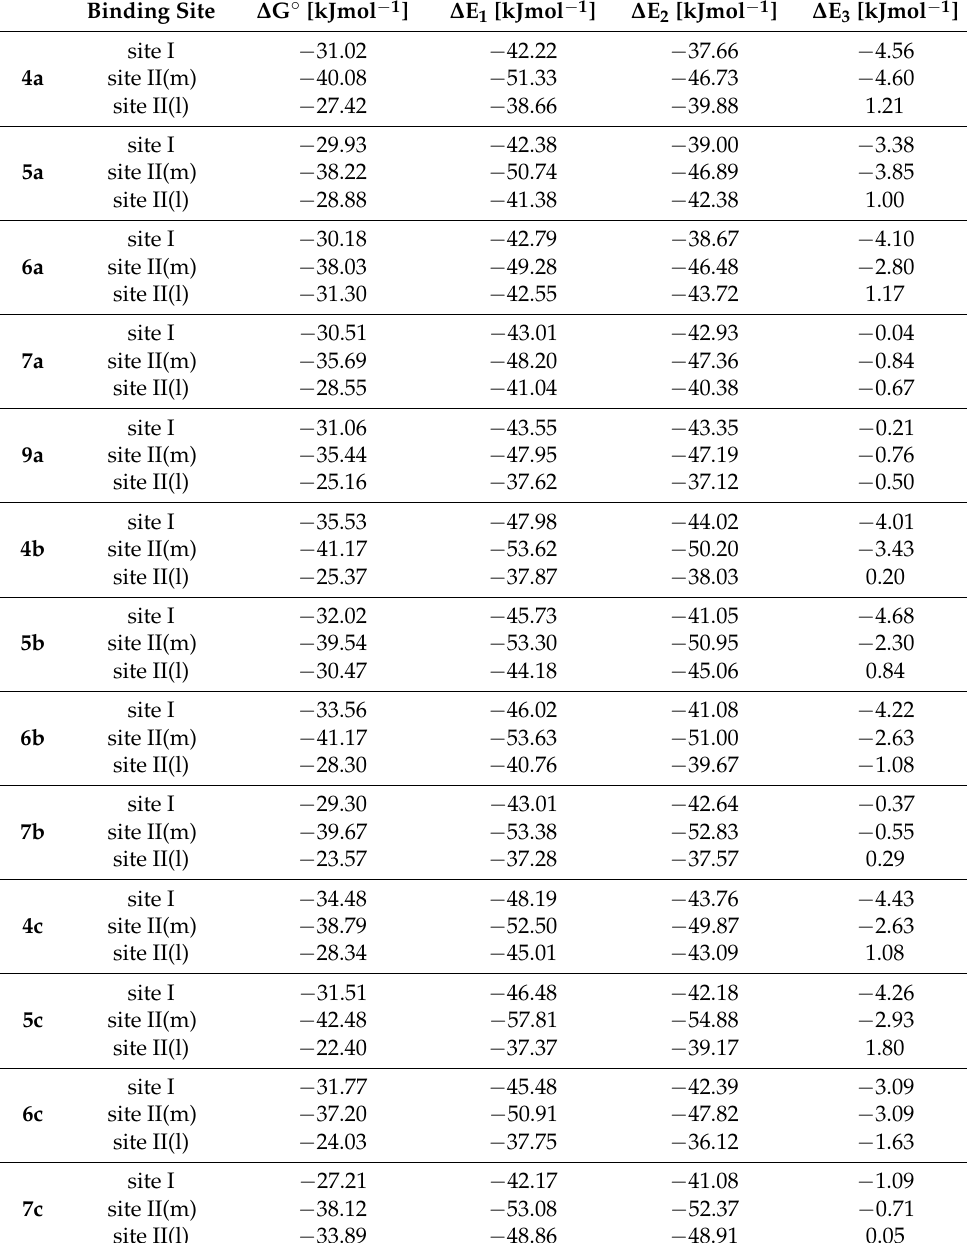
Table 8. Energies of the binding complexes BSA with studied compounds obtained from molecu- lar